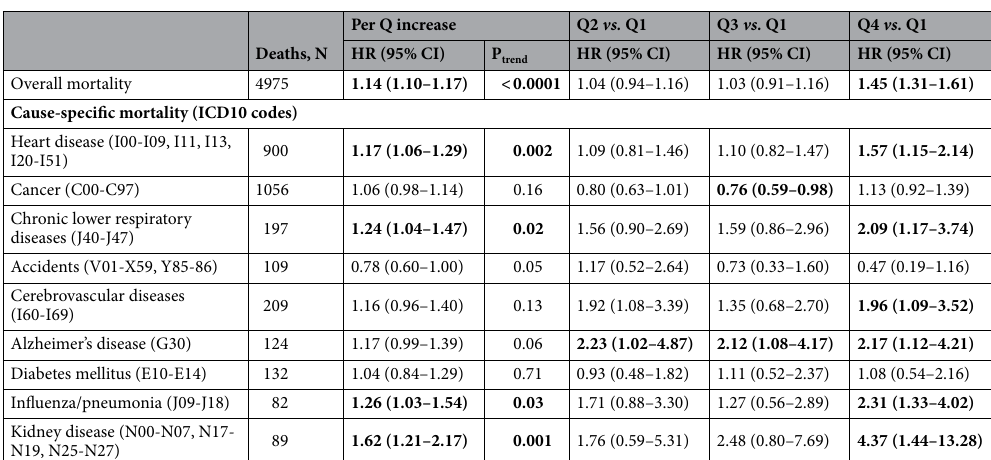
Table 2. Associations of neutrophil-to-lymphocyte ratio with overall and cause-specific mortality. Models are adjusted for age at baseline (continuous); sex; race/ethnicity (non-Hispanic white, non-Hispanic black, Mexican American, other Hispanic, other race/ethnicity); smoking (never, former, current smoker), body mass index (< 18.5, 18.5–24.9, 25–29.9, ≥ 30 kg/m 2 ); baseline presence of diabetes mellitus, hypertension, and arthritis; and total white blood cell count, except for the model for diabetes mellitus-specific mortality, which did not include adjustment for diabetes mellitus. Bolded values indicate statistical significance. CI interval, HR hazard ratio, Q quartile.